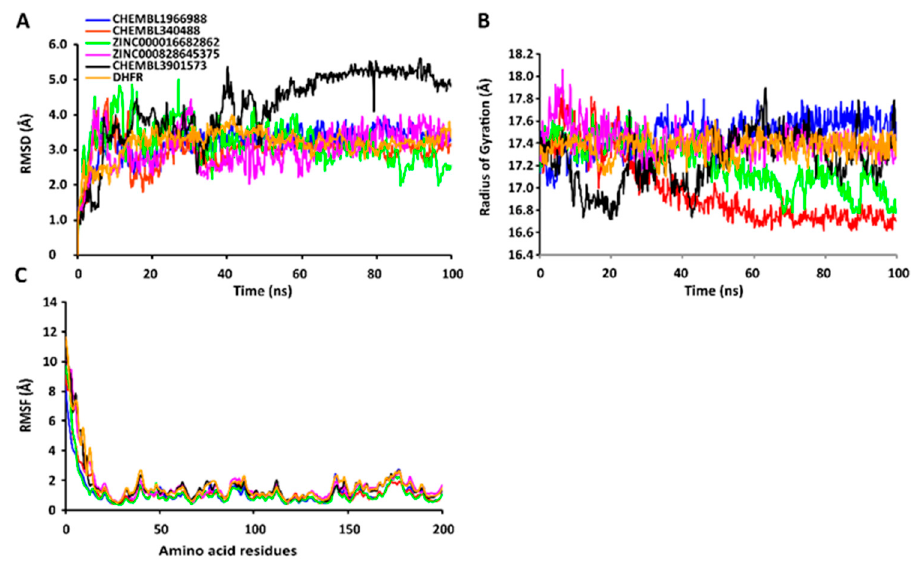
Figure 6. Stabilities of the protein-ligand complexes during 100 ns MD simulations. ( A ) RMSD values of the protein-ligand complexes fitted to the C α backbone of DHFR. The x -axis depicts the duration of simulation, while the y -axis represents the RMSD. ( B ) Analysis of the Rg values of the protein-ligand complexes. The x -axis depicts the duration of simulation, while the y -axis represents the deviations in Rg. ( C ) RMSF values of the C α backbone of DHFR. The x -axis represents the total number of residues, while the y -axis depicts the RMSF in Å. The different ligands complexed with DHFR are indicated by lines of different colors.